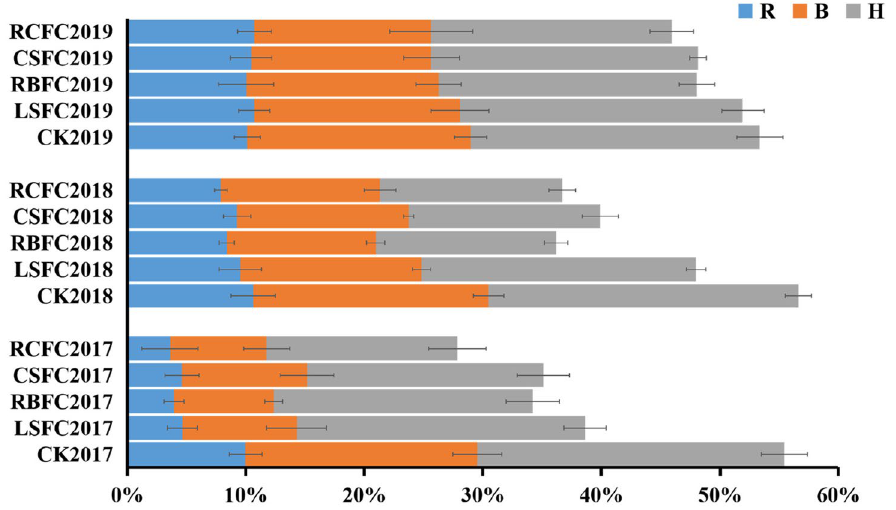
Figure 5. Population dynamics of the R. solanacearum in five treatment groups (CK, LSFC, RBFC, CSFC and RCFC) at rosette (R), budding (B) and harvesting (H) stage from 2017 to